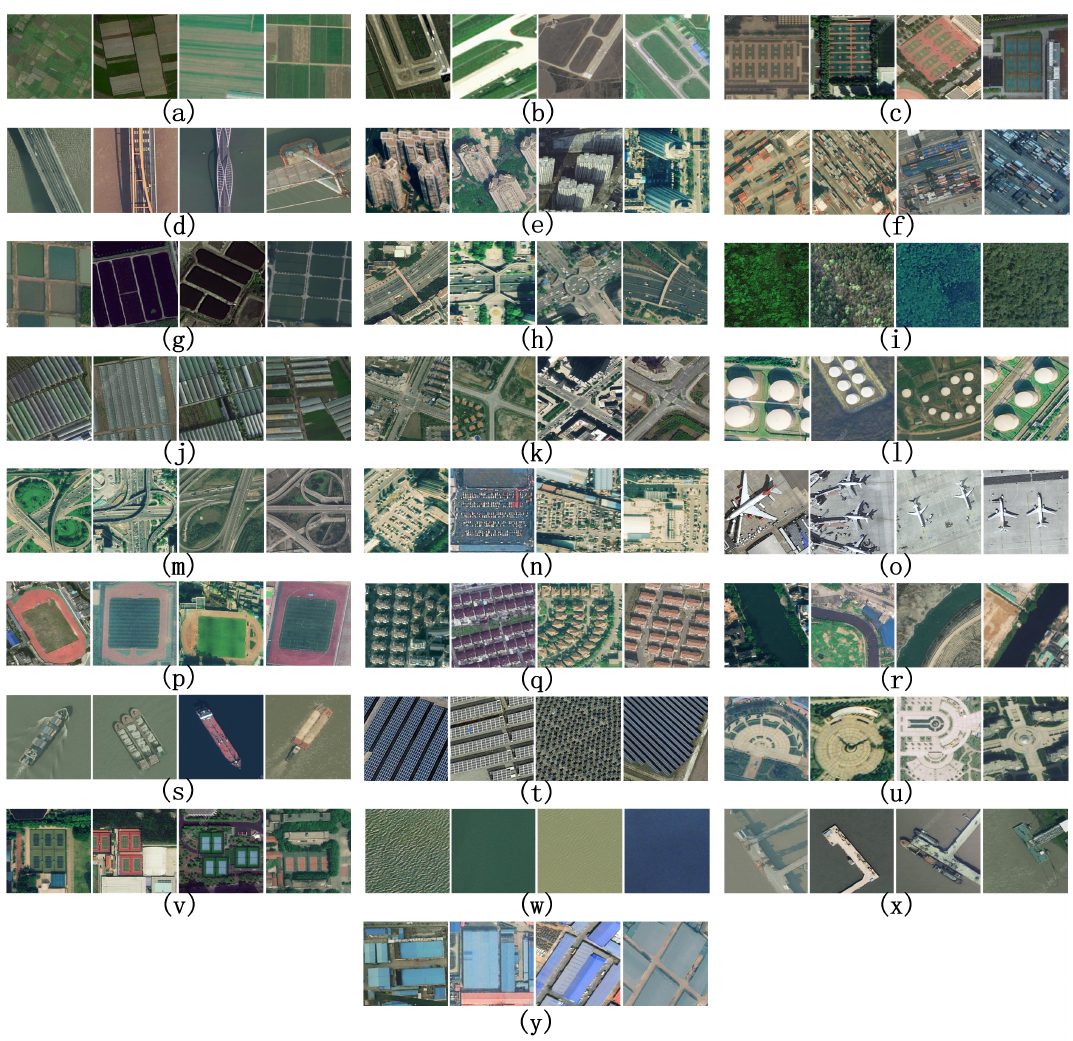
Figure 2. Ground truth dataset containing 500 images of each class. Four samples of the following classes are shown: ( a ) agricultural; ( b ) airport; ( c ) basketball court; ( d ) bridge; ( e ) building, ( f ) container; ( g ) fishpond; ( h ) footbridge; ( i ) forest; ( j ) greenhouse; ( k ) intersection; ( l ) oiltank; ( m ) overpass; ( n ) parking lot; ( o ) plane; ( p ) playground; ( q ) residential; ( r ) river; ( s ) ship; ( t ) solar power area; ( u ) square; ( v ) tennis court; ( w ) water; ( x ) wharf, and ( y )